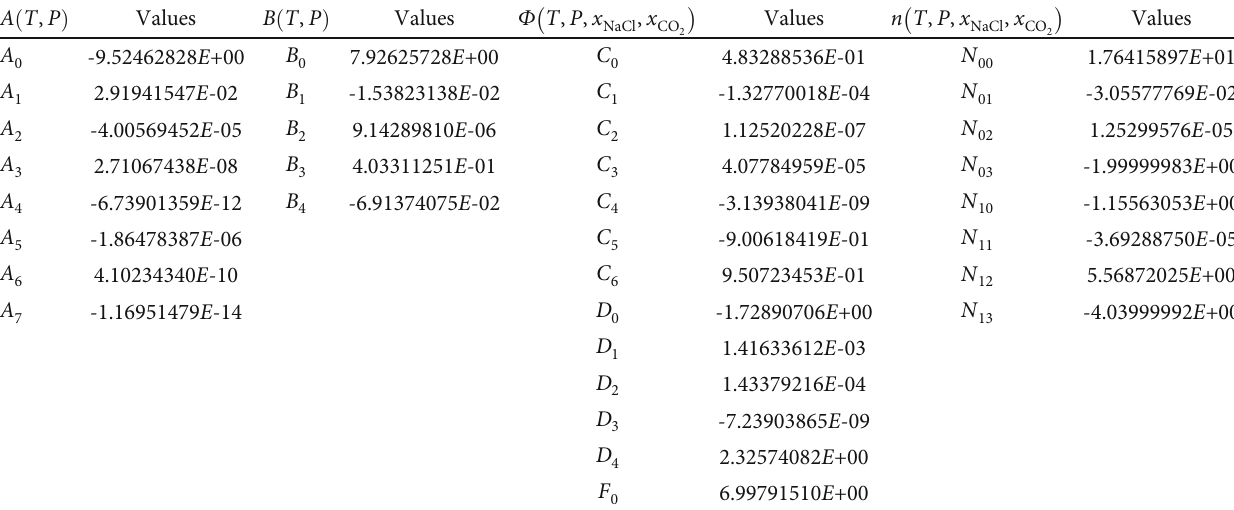
Table 2: Regressed constants for Eq.